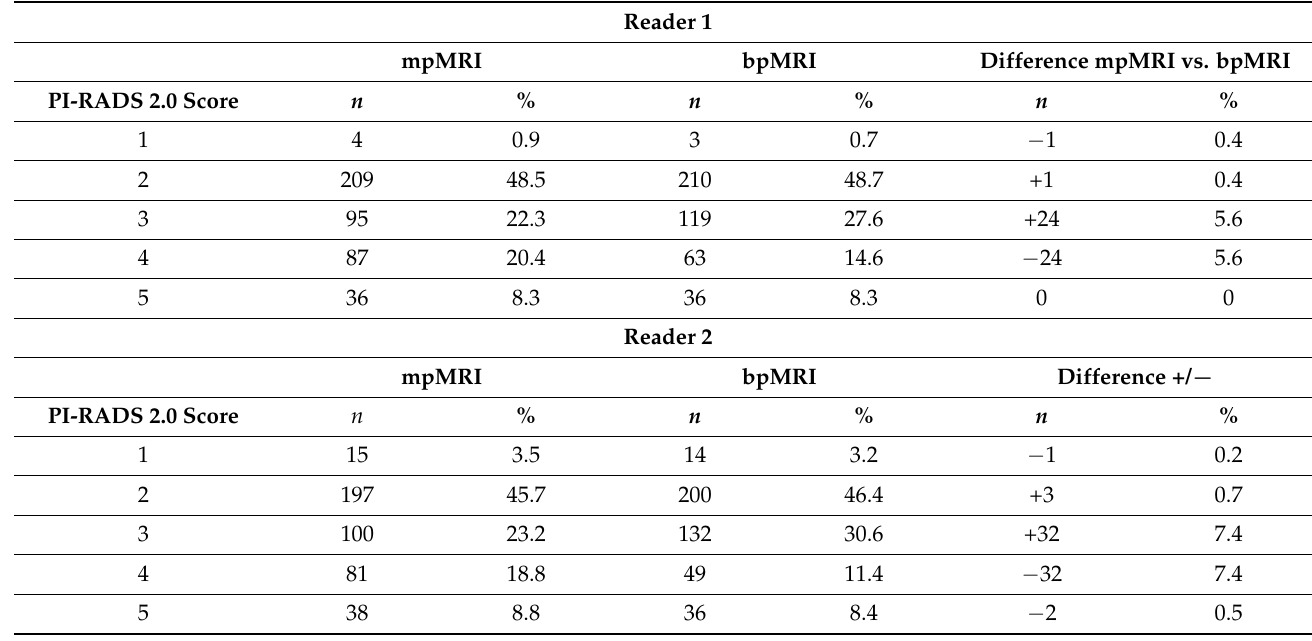
Table 4. Distribution of PI-RADS scores: distribution of mpMRI and bpMRI index lesions ( n , %) on the different PI-RADS score levels of the two